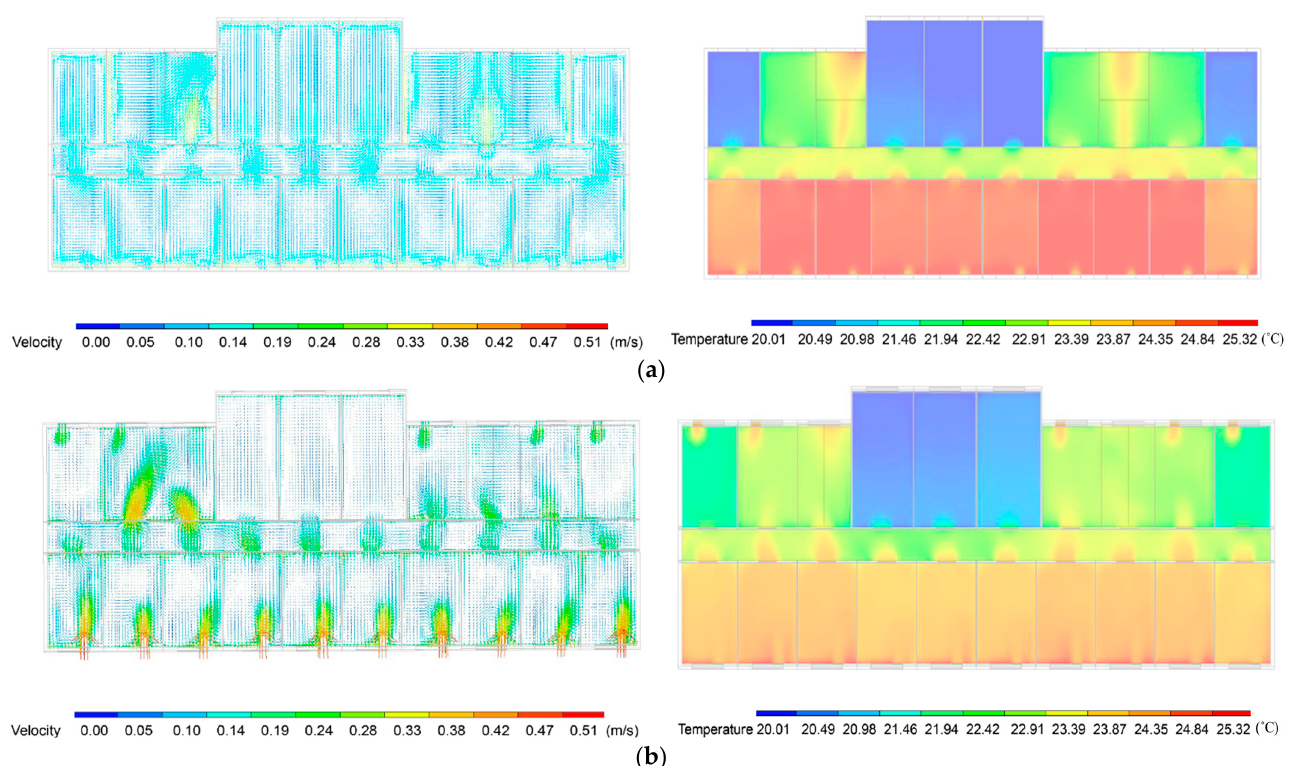
Figure 18. CFD calculated air velocities and temperatures for the top floor of the naturally ventilated building: ( a ) internal doors are closed and ( b ) doors are opened (cross-ventilation) (27 October, 16:00).